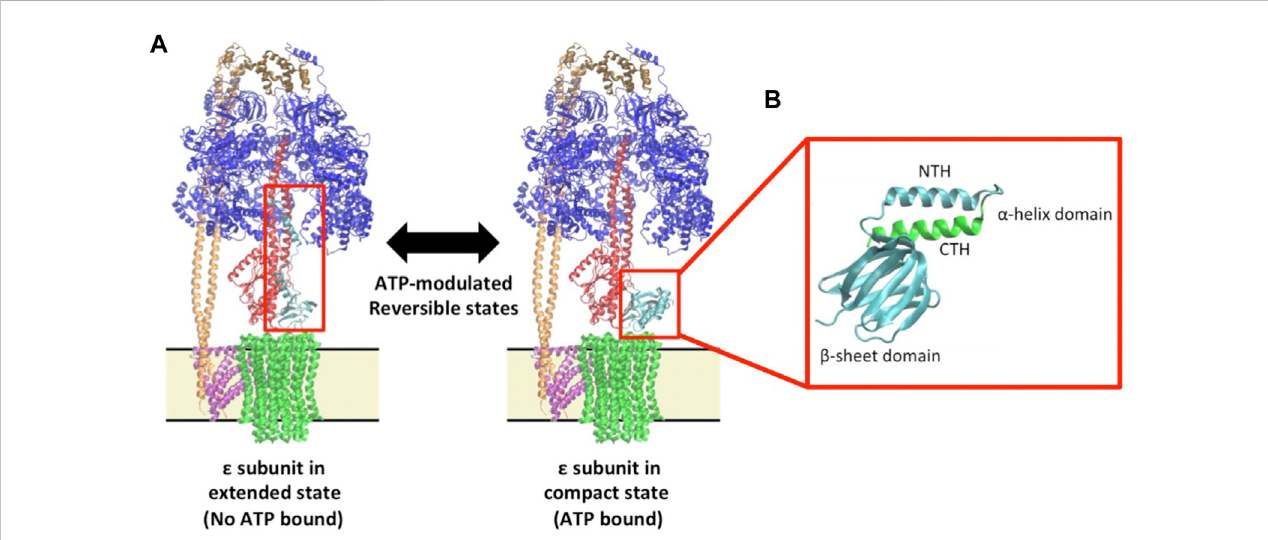
FIGURE 1 Epsilon structure and functioninthecontextoftheF 1 F o ATPsynthase (A) The Escherichia coli F 1 F o multi-subunitcomplex proteinisdisplayedshowinga structure with the ε ; subunit in the extended ‘ up-state ’ in which ATP is not bound (Left: 5T4O) and a structure with the with ε ; subunit in the compact ‘ down- state ’ inwhichATPisbound(Right:5T4O,exchangingchainHwith1AQT).TheF 1 subunits, α 3 β 3 γδε ,areshowninblue,blue,red,brownandaqua,respectively, andthemembrane-boundF o subunits, ab 2 c 10 ,areshowninpink,orange,andgreenrespectively.MembraneboundariesaroundtheF o areindicatedbya yellow box boundby black lines. The red boxes encompass the ε ; subunit in either state. (B) A zoom in of the ε ; subunit in the “ down-state ” showing the sheet and helical domains. For clarity of relative orientation, the N-terminal helix (NTH) and β -sheet domain are shown in cyan while the C-terminal helix (CTH) is shown in